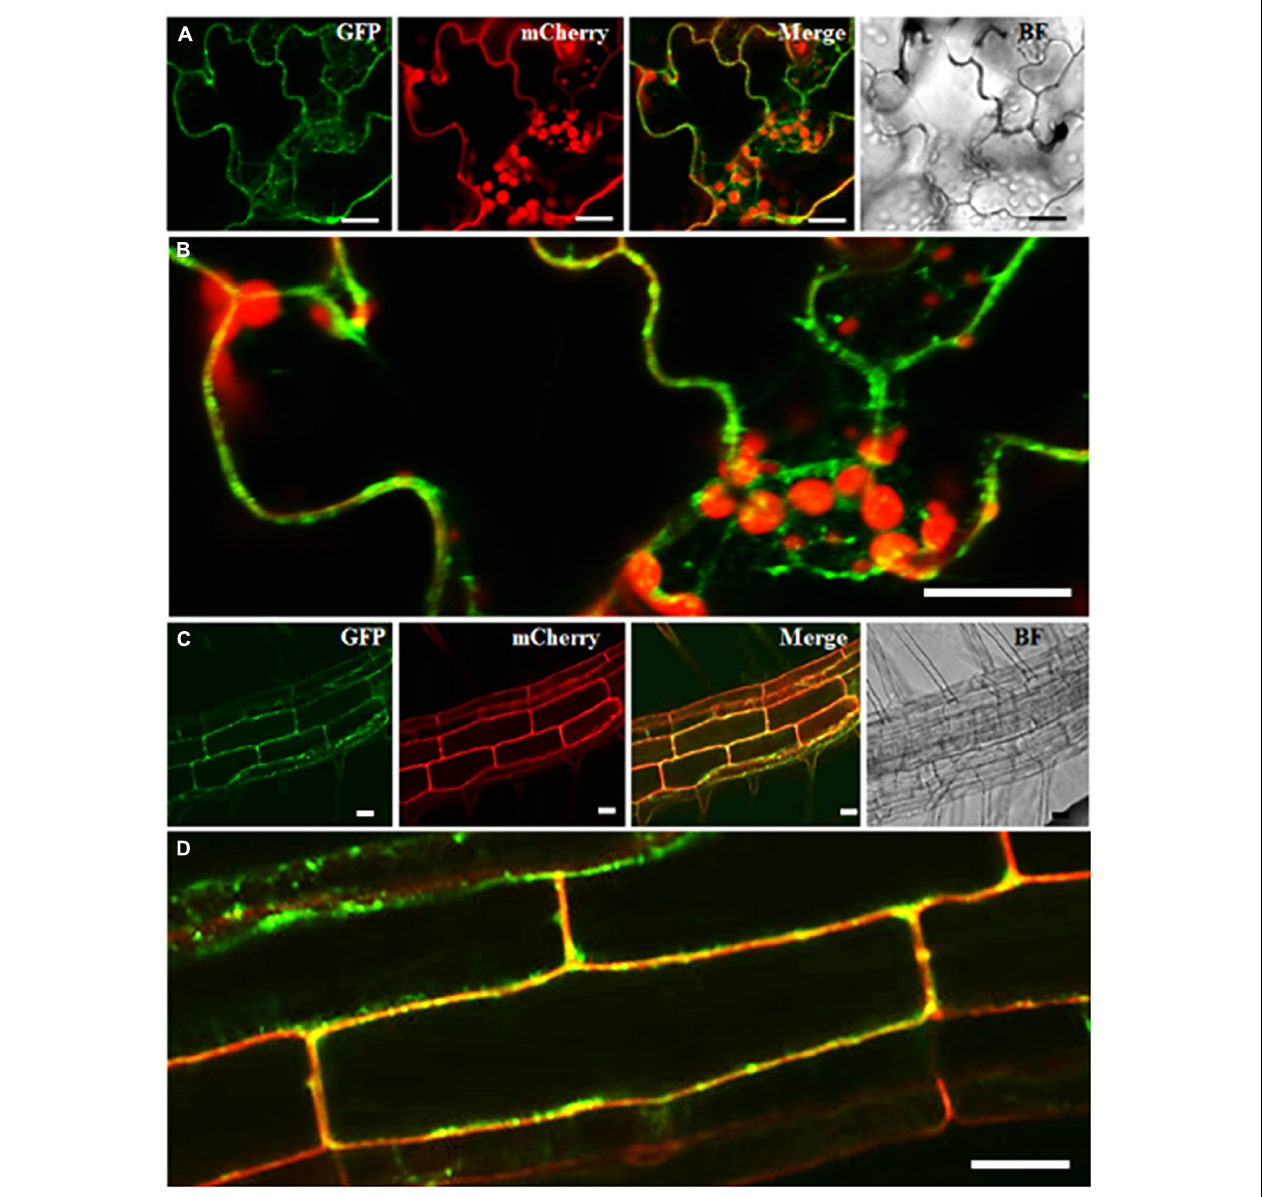
FIGURE 6 | Spatial intra-cellular distribution of RabA2b:GFP. Representative confocal fluorescent microscopy images of double transgenic plants expressing Pro35S:GFP-RabA2b and membrane marker aquaporin PIP2a-mCherry. Panels (A,C) are the image of leaf epidermis and elongated root cells, respectively, of 5 days old plant showing Rab: GFP signal in green, PIP2A: mCherry signal in red, merge of green and red channel, and bright-field of the focused sample. Panels (B,D) are the enlarge area of leaf and root highlighted by white rectangle box showing merge image. Scale bar = 20 µ